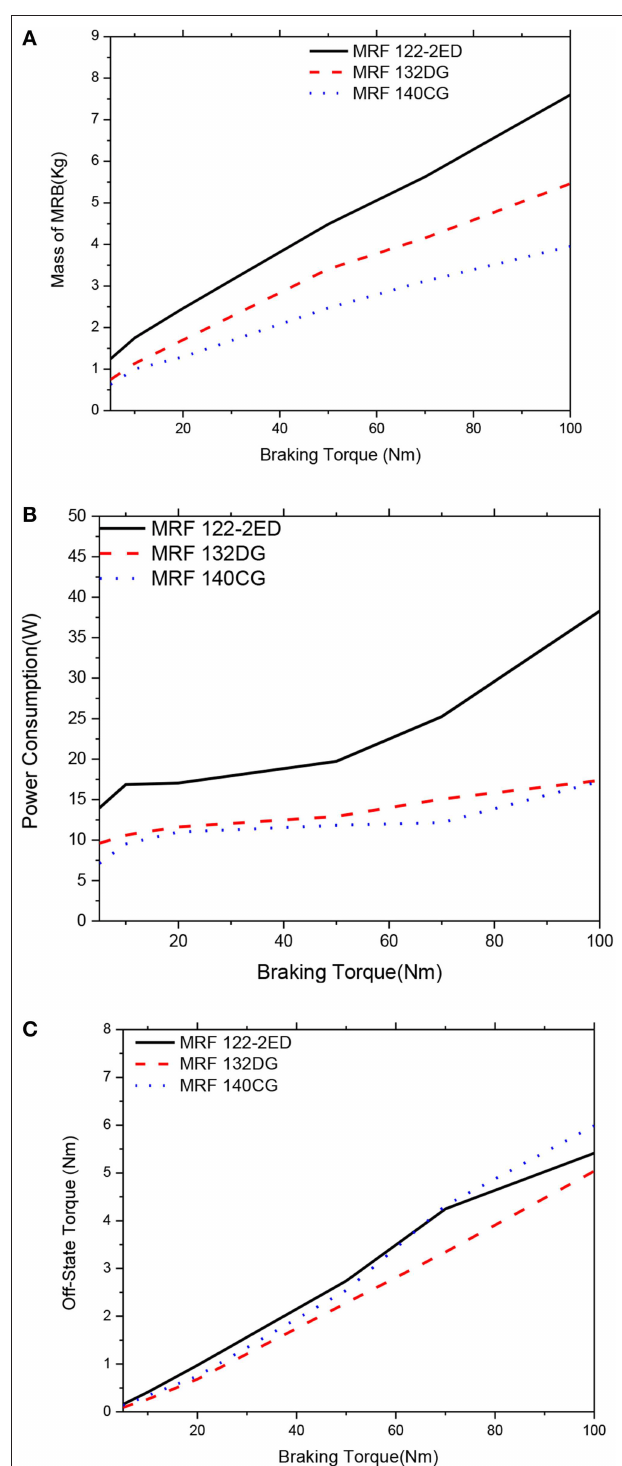
FIGURE 15 | Multi-objective optimization results of the MRBs as a function of braking torque of side-coil MRB, α m = α P = 0.5 , α To = 0. (A) Mass as a function of braking torque, (B) Power consumption as a function of braking torque, (C) Off-state torque as a function of braking torque.